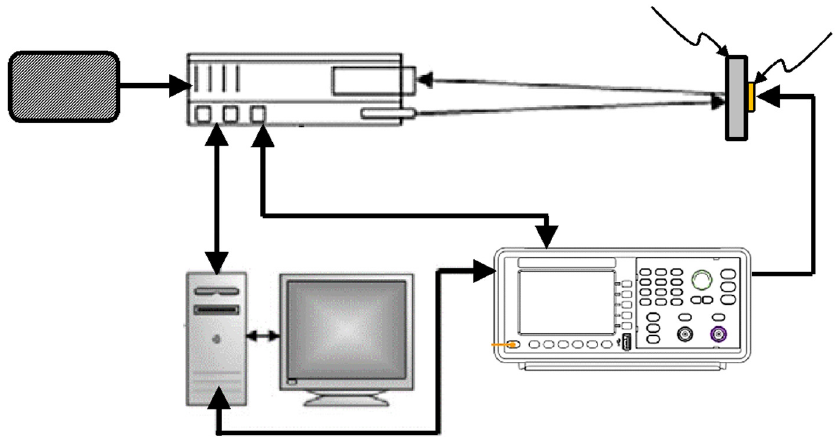
Figure 6. Schematic illustration of an ESPI